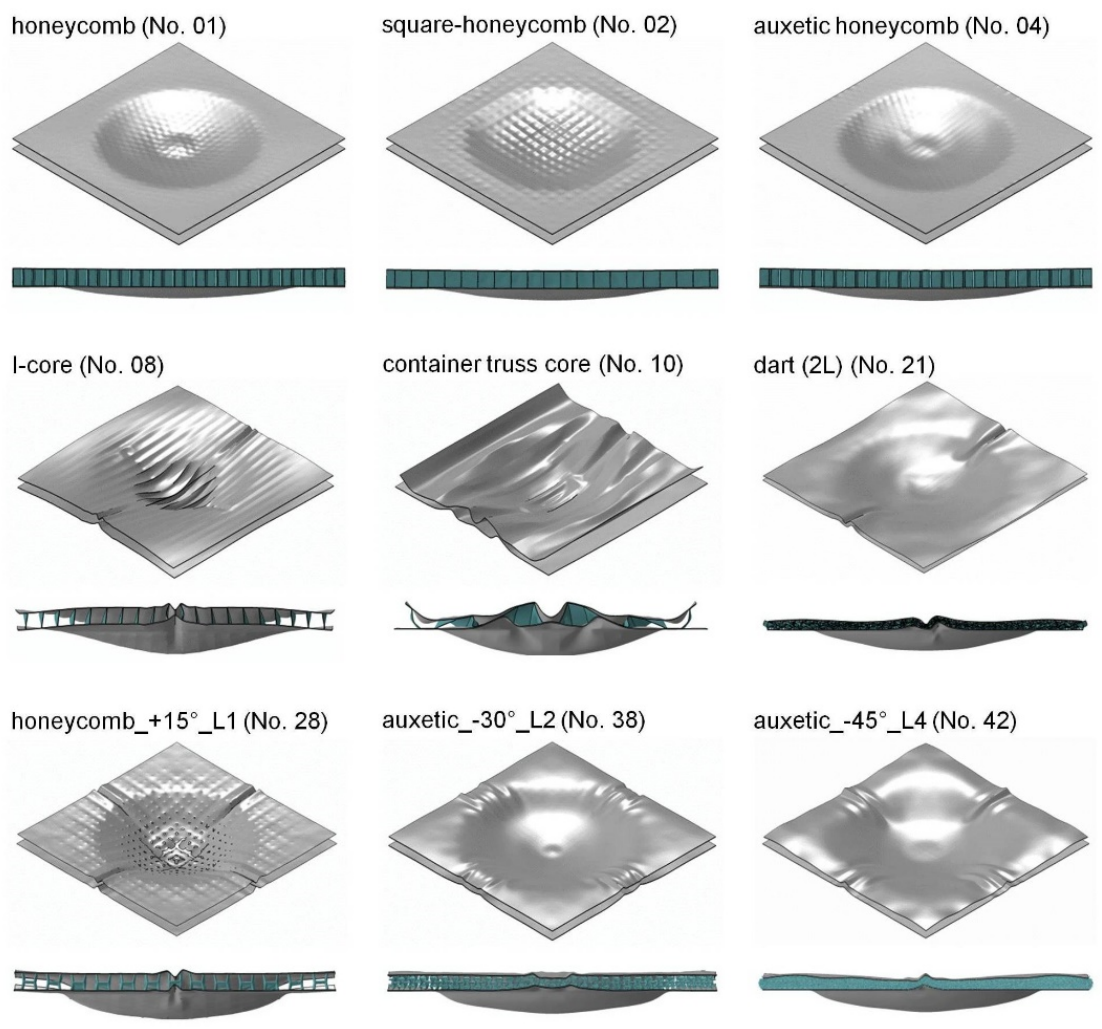
Figure 17. Deformation states of selected sandwich variants under blast loading (t = 0.6 ms).